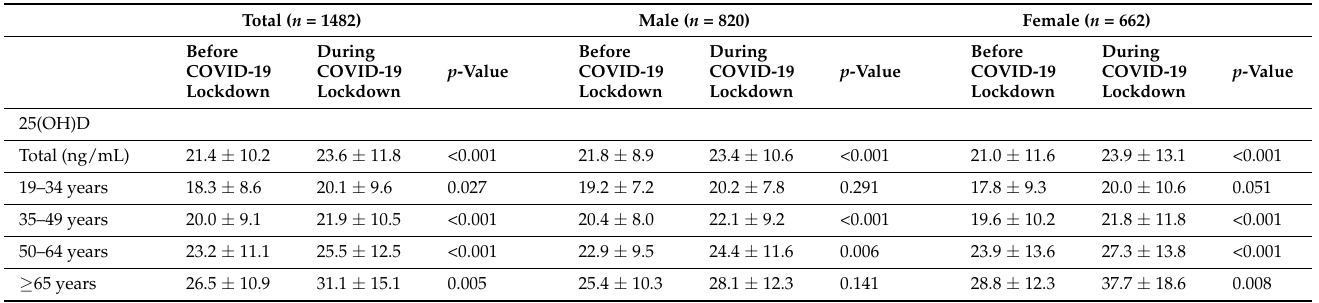
Table 2. 25(OH)D levels according to gender in different age groups before and during the COVID-19 lockdown